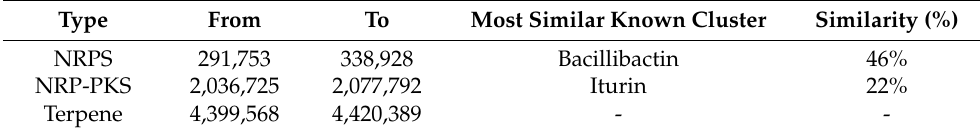
Table 2. List of secondary metabolites in Viridibacillus sp.